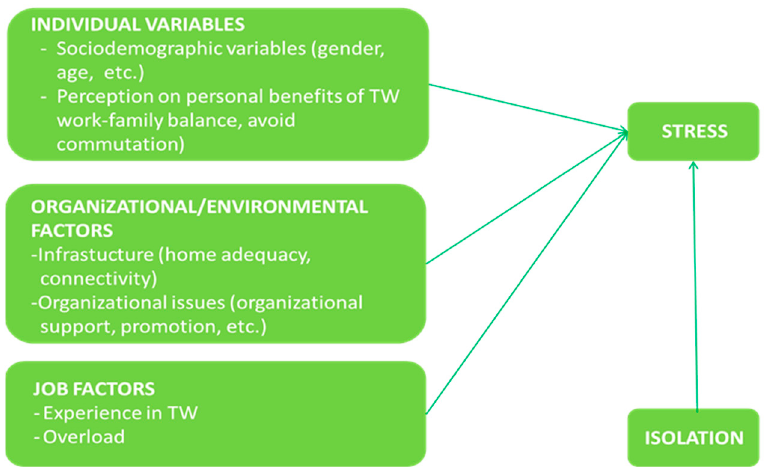
Figure 1. Framework used to explain perceived stress because of working from home.